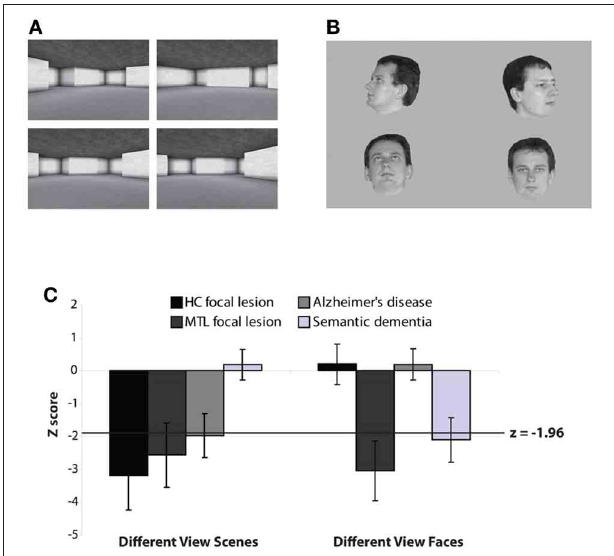
FIGURE 2 | Example trials from the (A) Different View Scenes and (B) Different View Faces oddity judgment tasks used in Lee et al. (2005b, 2006). On each trial participants indicated which image was different from the other three, simultaneously presented, images. All stimuli were trial-unique. For both examples, the odd-one-out is in the top right corner. (C) Z -scores for patients with selective hippocampal lesions (HC focal lesion), broader MTL lesions that included the hippocampus and perirhinal cortex bilaterally (MTL focal lesion), cases with Alzheimer’s disease (predominant HC damage), and patients with semantic dementia (predominant PRC